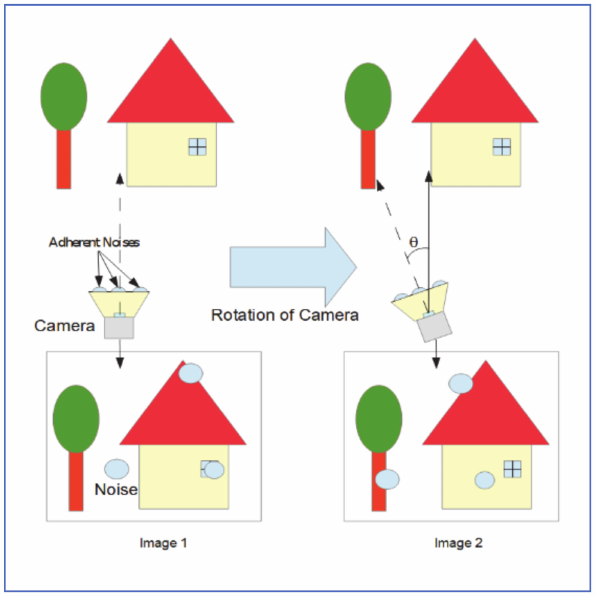
Figure 12. Using a pan-tilt camera for adherent raindrop detection